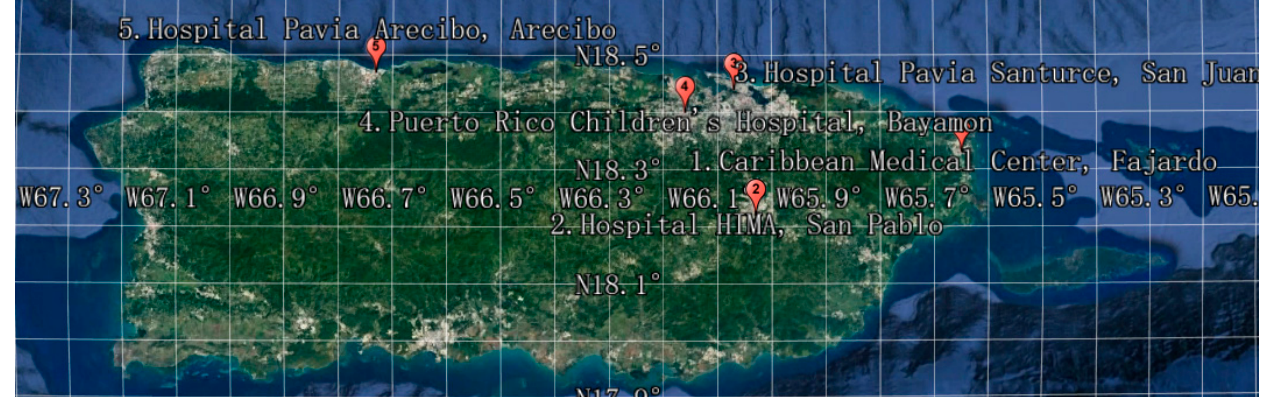
Figure 1. Location distribution map (WGS 48, ESPG:4326). Table 6. Anticipated Medical Package Demand.